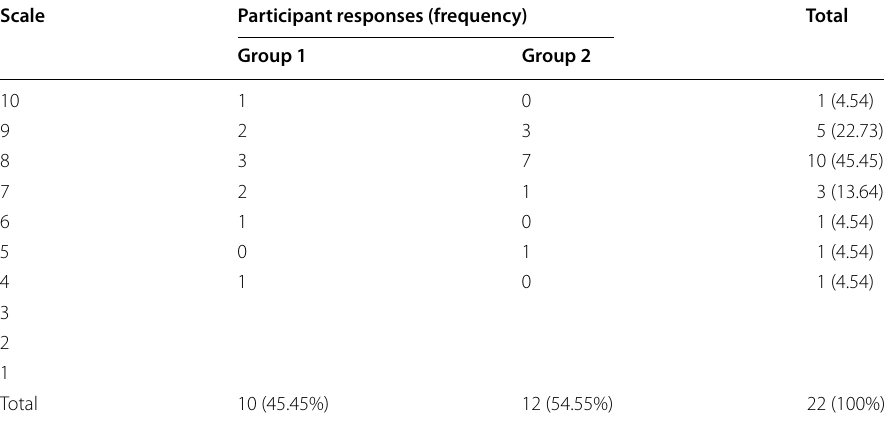
Table 6 Effectiveness of the Jiegnote transcription software